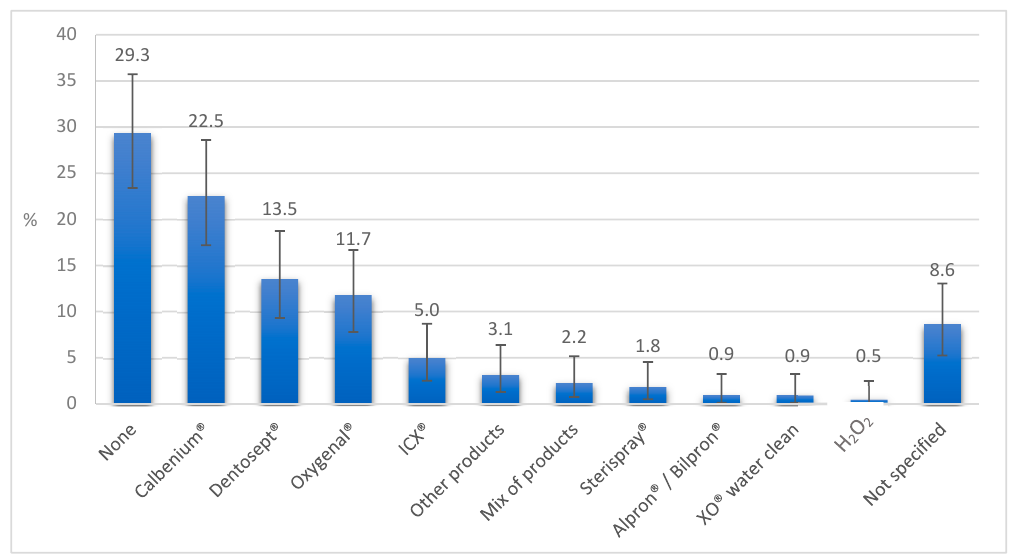
Figure 2. Products used for the chemical treatment of water in the 223 dental care units studied in Eastern France in 2016. Note: Calbenium ® contains quaternary ammonium, EDTA, and sodium tosylchloramide; Dentosept ® , Oxygenal ®, and XO ® water cleaners are made of H 2 O 2 ; ICX ® contains sodium percarbonate, silver nitrate, and cationic surfactants; Sterispray ® contains benzalkonium chloride, chloramine T, and EDTA; Alpron ® /Bilpron ® contain EDTA and polyaminopropyl biguanide with sodium tosylchloramide for Alpron ® and with ester p-hydroxybenzoate for Bilpron ® . Table 1. Flushing times of the dental unit waterlines in 153 dental offices studied in Eastern France in 2016.